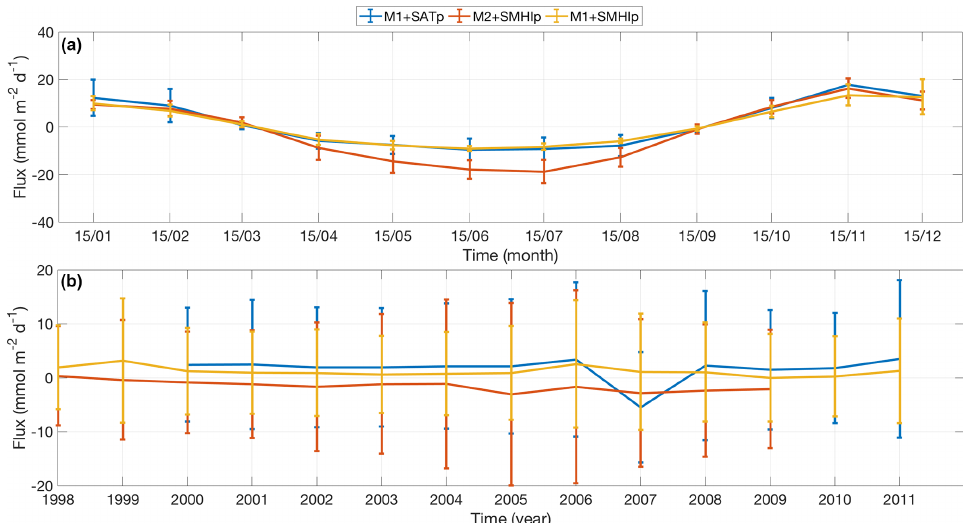
Figure 9. The air–sea CO 2 flux estimate evolution with Method 1 and the SATp product (blue); Method 2 and the SMHIp product (red); and Method 1 and the SMHIp product (yellow). (a) For a year and (b) on average for all the